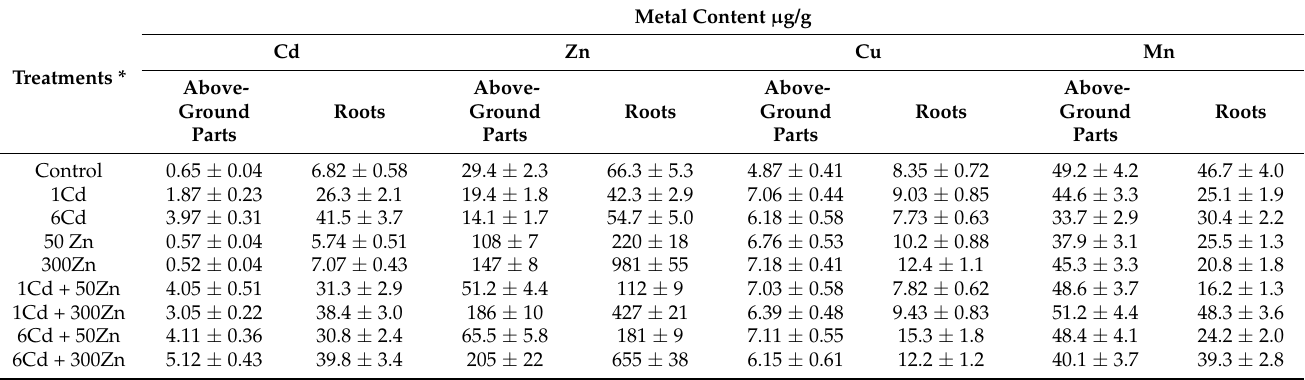
Table 1. Copper and manganese contents with relevant standard deviations ( n = 5) determined in above-ground parts and roots of lemon